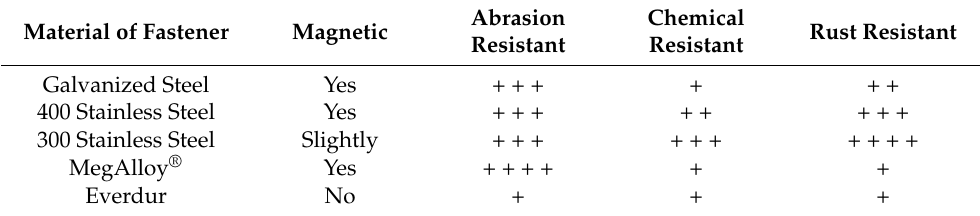
Figure 22. Rivet solid plate fastening: ( a ) general view using five contact points at each end of the belt; ( b ) cross section view using seven contact points at each end of belt [25]. Table 10. Fastener Material Characteristics ranging from one plus sign (+) to four plus signs (+ + + +) [25].